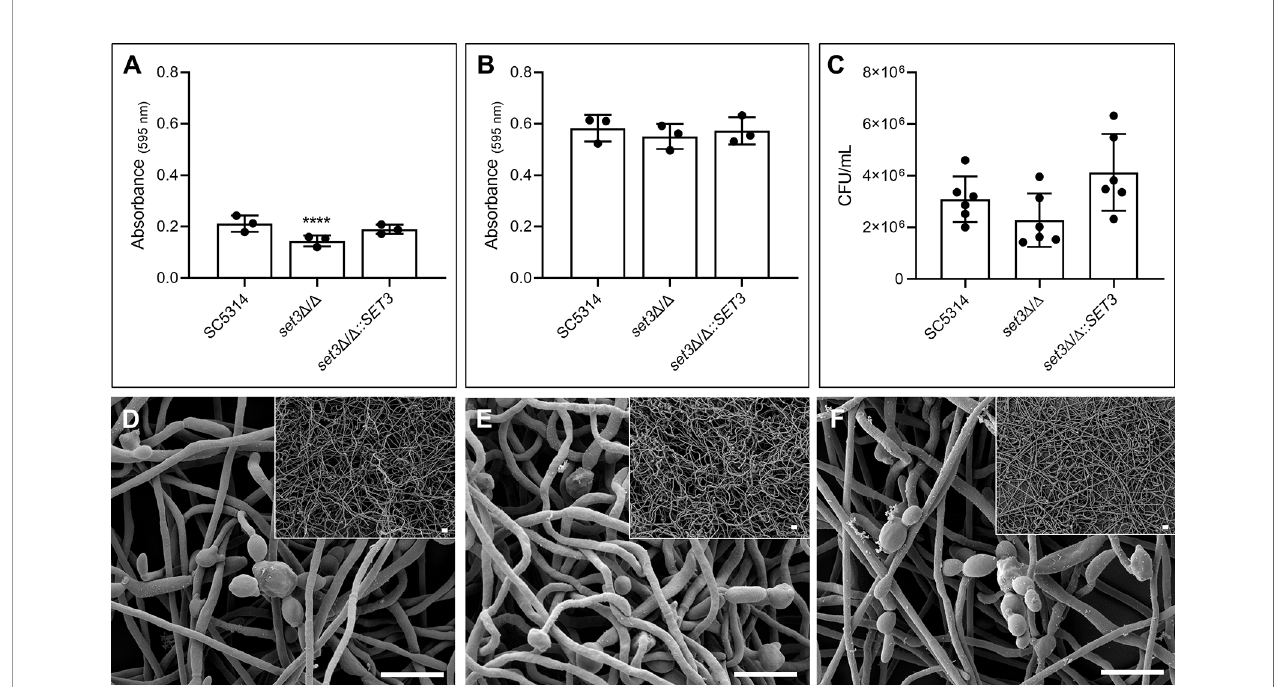
FIGURE 1 | Effect of SET3 deletion on Candida albicans monomicrobial bio fi lms. Monomicrobial bio fi lm biomass after 6 h (A) and 48 h (B) of the homozygous mutant of SET3 ( set3 D / D ) as well as the homozygous mutant with add-back of the wild-type gene ( set3 D / D ::SET3 ). Colony forming units (CFU) of mature C. albicans bio fi lms are indicated in (C) as well as bio fi lm morphology of mature bio fi lms in (D) (SC5314), (E) ( set3 D / D ) and (F) ( set3 D / D ::SET3 ). Small panels on right corners indicate bio fi lms with lower magni fi cation. Scale bars on all panels indicate 10 m m. *Signi fi cantly different from wild type (SC5314) (**** P <